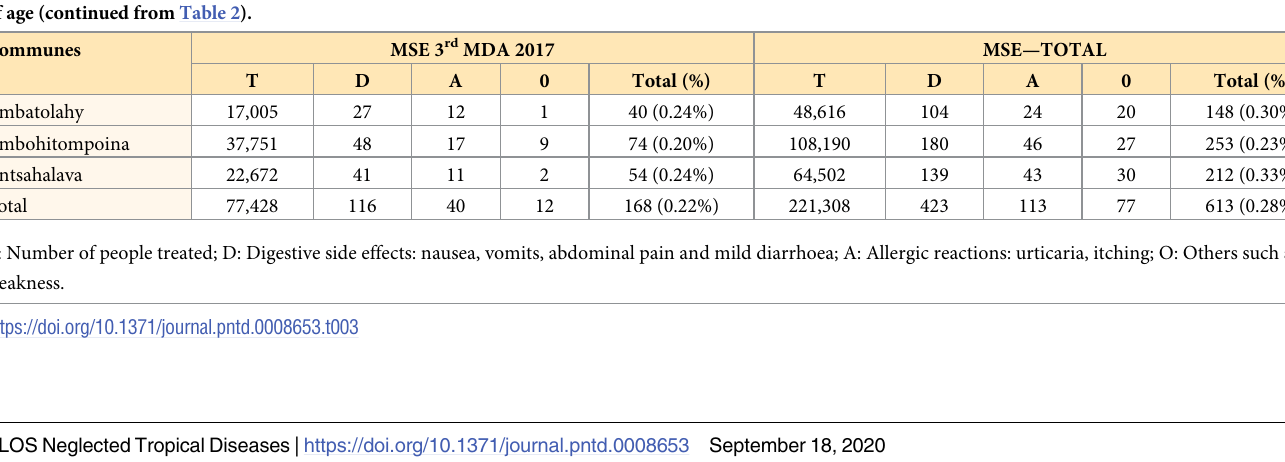
T: Number of people treated; D: Digestive side effects: nausea, vomits, abdominal pain and mild diarrhoea; A: Allergic reactions: urticaria, itching; O: Others such as weakness.